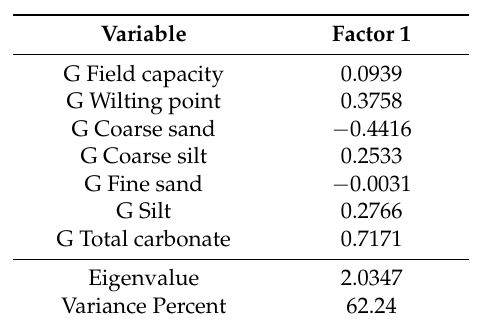
Table 5. Structural composition of the first regionalized factor of the spherical model at longer range (33.80 m) with eigenvalue and explained variance